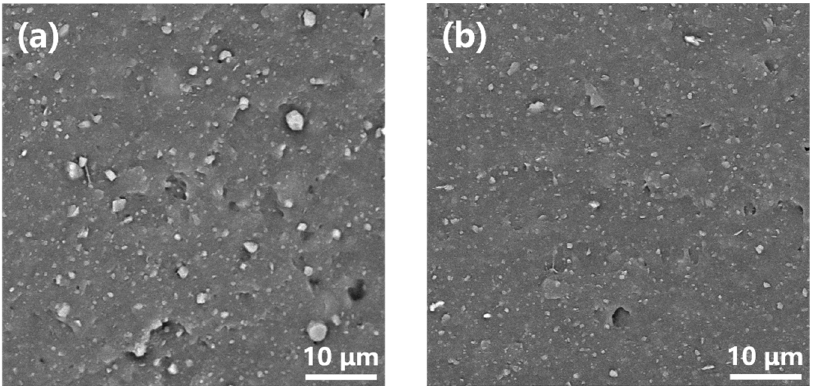
Figure 6. Observation of tensile fractured surface of vulcanizates by SEM ( a ) illite-4/SBR, ( b ) K-illite- 4/SBR.